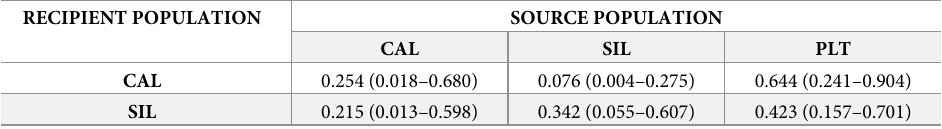
Table 4. Estimates of male gametic gene flow rates among Pinus sylvestris study populations. RECIPIENT